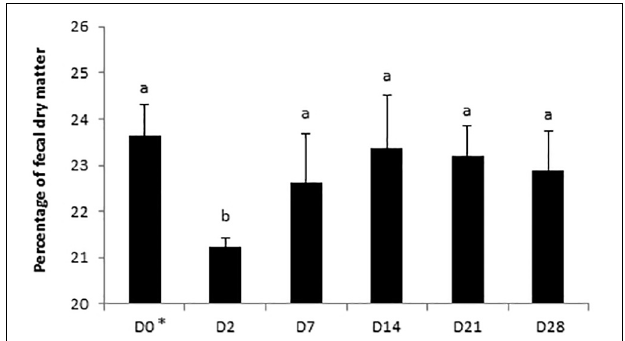
FIGURE 5 | Variations of the percentage of dry matter in fecal samples of horses subjected to an oral challenge TMS from D0 to D4 by day. Means with different superscripts differ significantly at P < 0.05. ∗ D0: Basal value before the first TMS